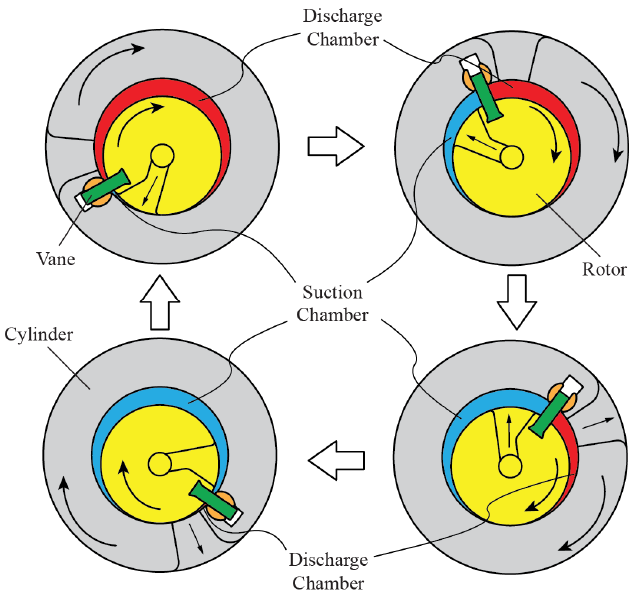
Figure 4. Revolving vane compressor working principle.